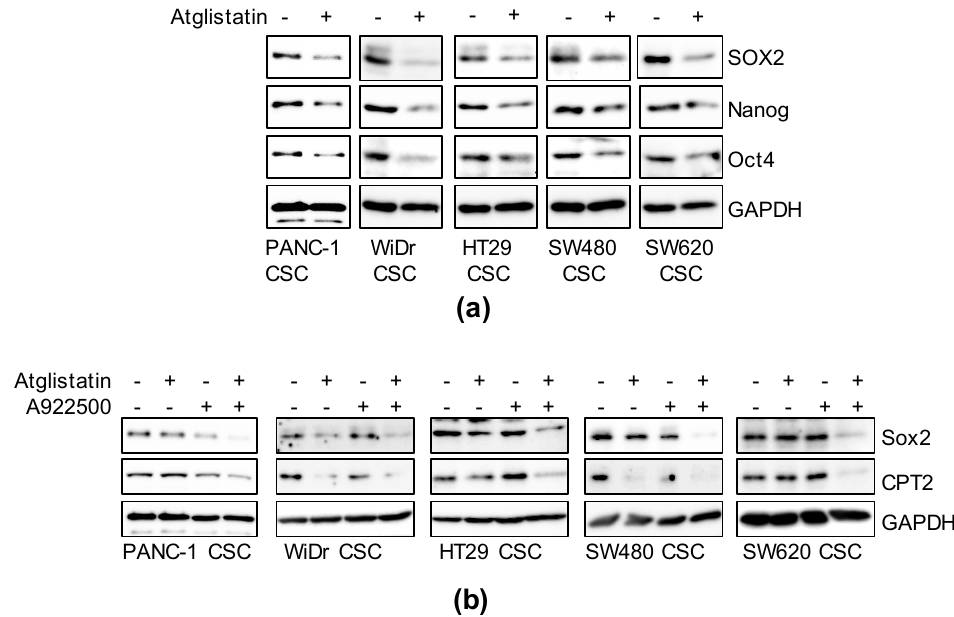
Figure 6. The essential role of triglyceride metabolism in the maintenance of cancer stemness. ( a ) Cells treated with 50 µ M Atglistatin for six days were subjected to immunoblot analyses as indicated. ( b ) Cells treated with 10 µ M Atglistatin and 5 µ M A922500 as described above were subjected to immunoblot analyses for the related proteins. Similar results were obtained from two independent biological